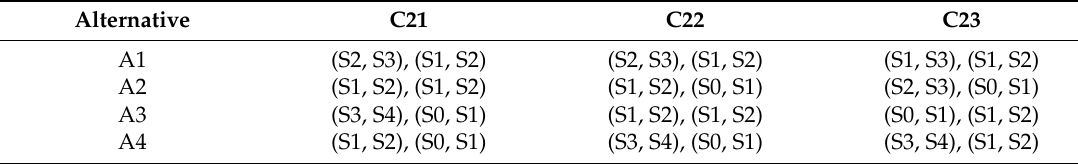
Table 4. Performance 2DUIVs values of the last type sub-criteria.